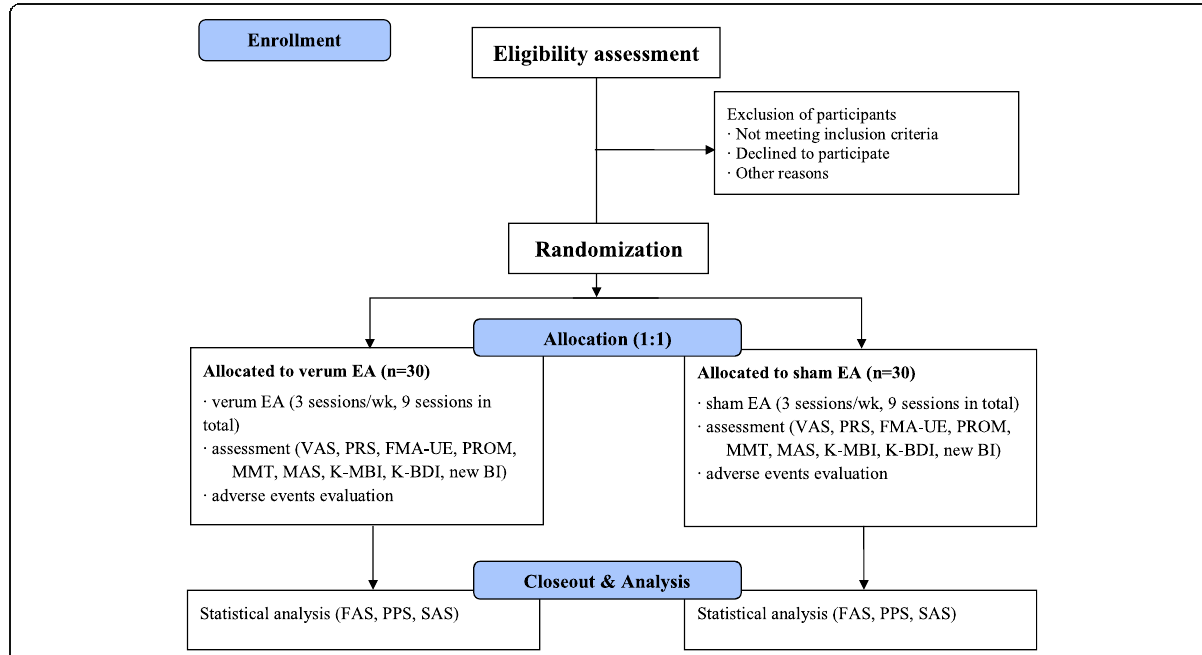
Fig. 1 Schematic chart of the overall study. The template is from the CONSORT 2010 flow diagram. EA electroacupuncture, VAS visual analog scale, PRS pain rating scale, FMA-UE Fugl-Meyer assessment upper extremity, PROM passive range of motion, MMT manual muscle test, MAS modified Ashworth scale, K-MBI Korean version of modified Barthel index, K-BDI Korean version of Beck depression inventory, BI blinding index, FAS full analysis set, PPS per protocol analysis set, SAS safety assessment